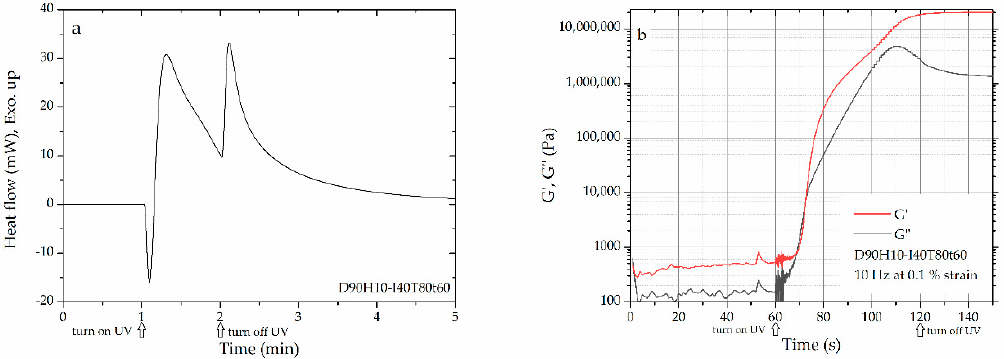
Figure 3. The representative data of ( a ) differential scanning calorimetry (DSC) and ( b ) rheological measurements.